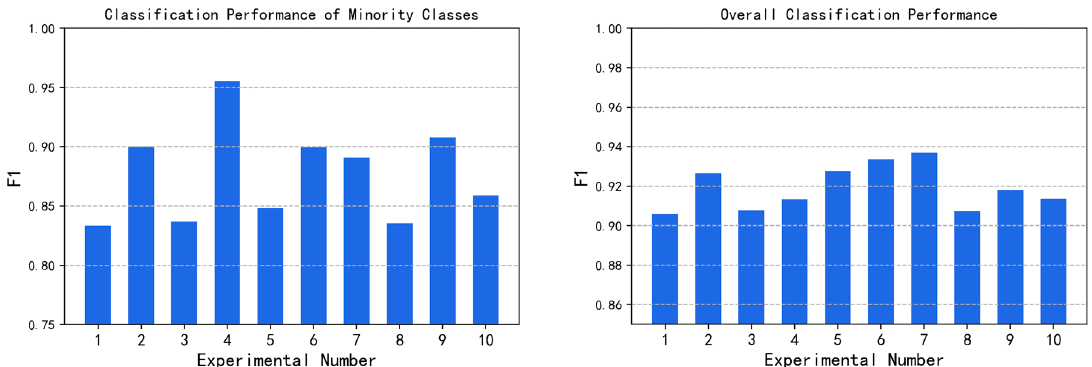
Figure 10. The classification performance of Moore dataset.